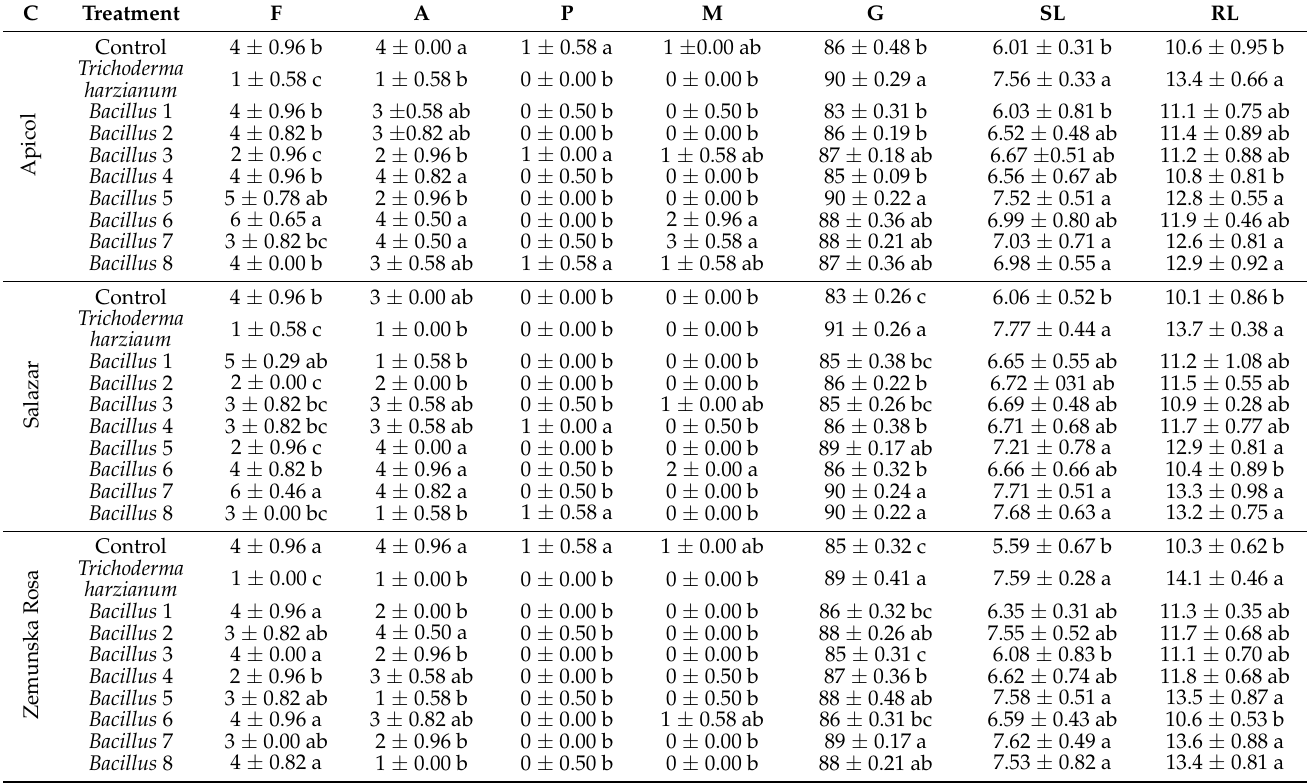
Table 10. Influence of Trichoderma harzianum isolate and eight different isolates of Bacillus spp. to influence germination, seedling growth, and the presence of some plant-pathogenic fungi ( Fusarium sp., Alternaria sp., Penicillium sp., and Mucor sp.), seed germination, and initial seedling growth (primary shoot and root length) on seeds of three wheat